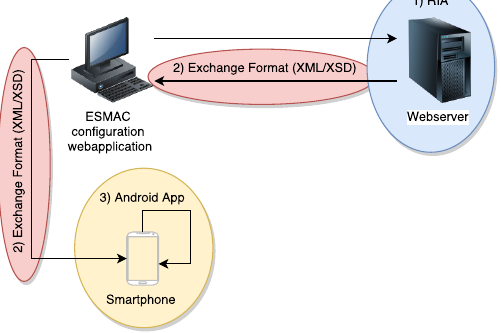
Figure 1: Core components of the ESMAC